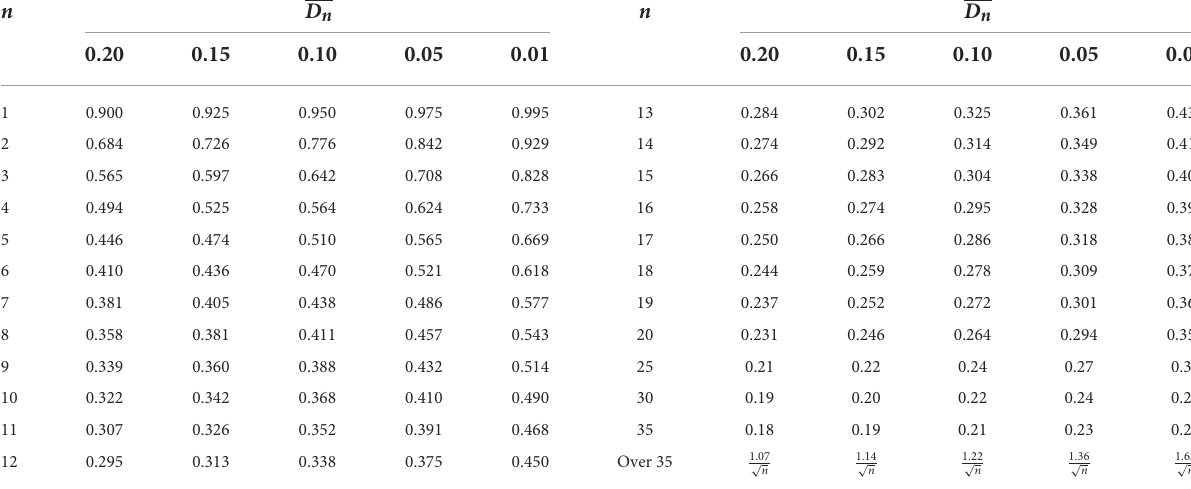
TABLE 2 At the significance level of 0.20, 0.15, 0.10, 0.05, 0.01, the critical value of the KS test D statistic, n is the sample size (Massey,